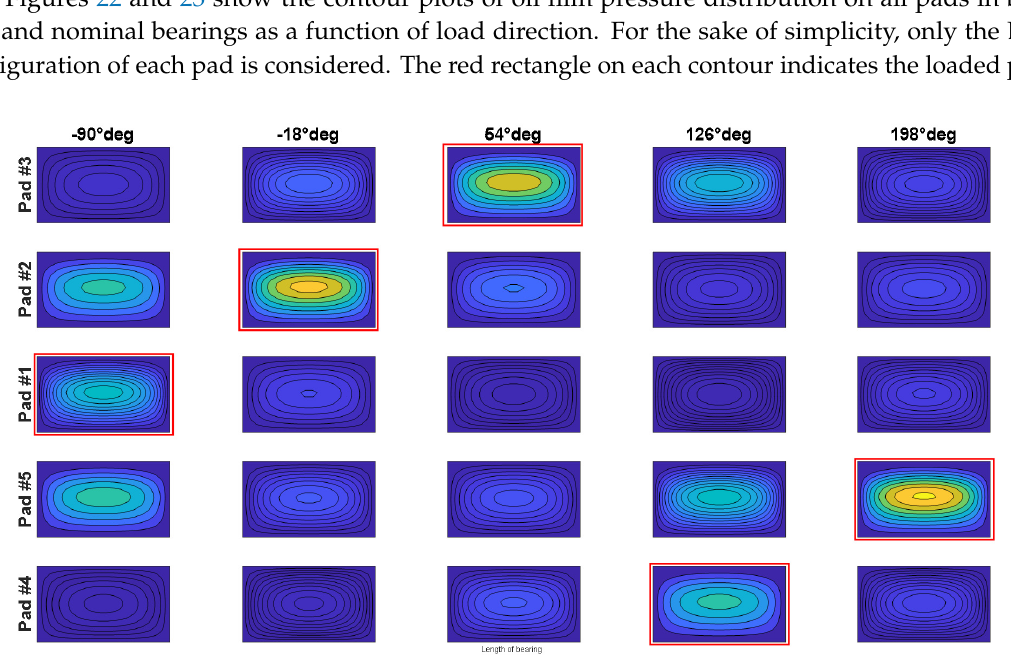
Figure 22. Predicted pressure distribution with LOP configuration of test bearing.